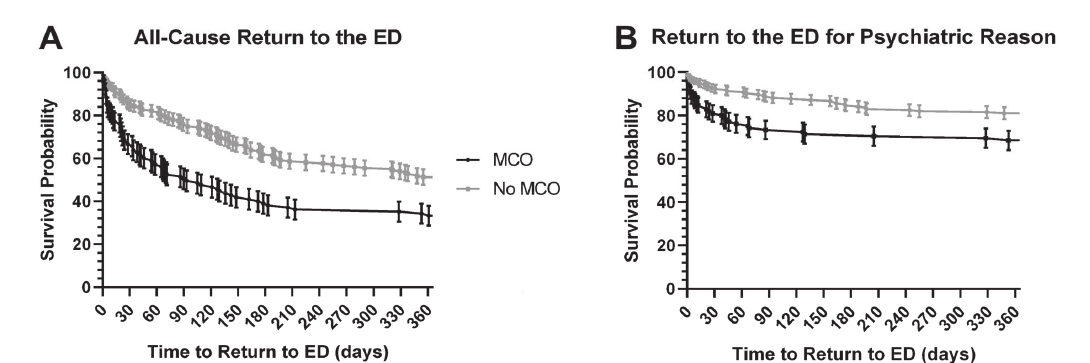
Figure 2. Survival curves of return to the emergency department by mobile crisis outreach exposure status. ED , emergency department; MCO , mobile crisis